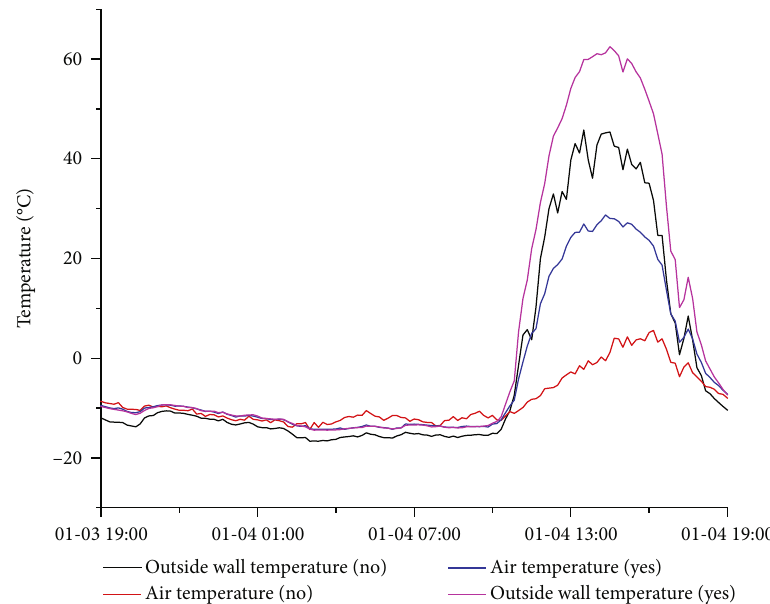
Figure 10: Temperature comparison when the fan stops working.